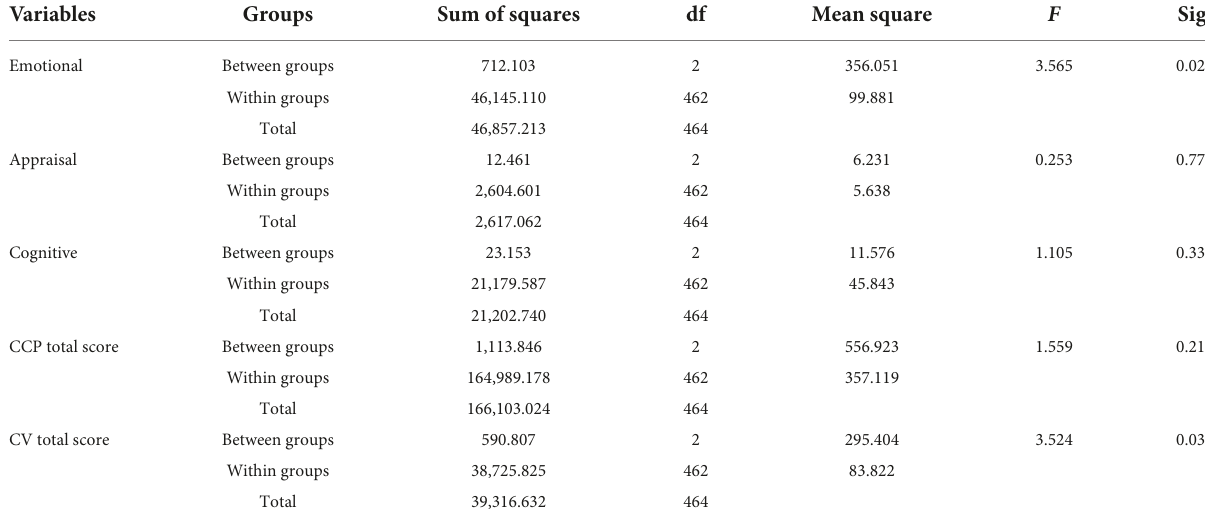
TABLE 9 Results of group differences in climate change perception (CCP) and climate values (CV) due to age group variable. Variables Groups